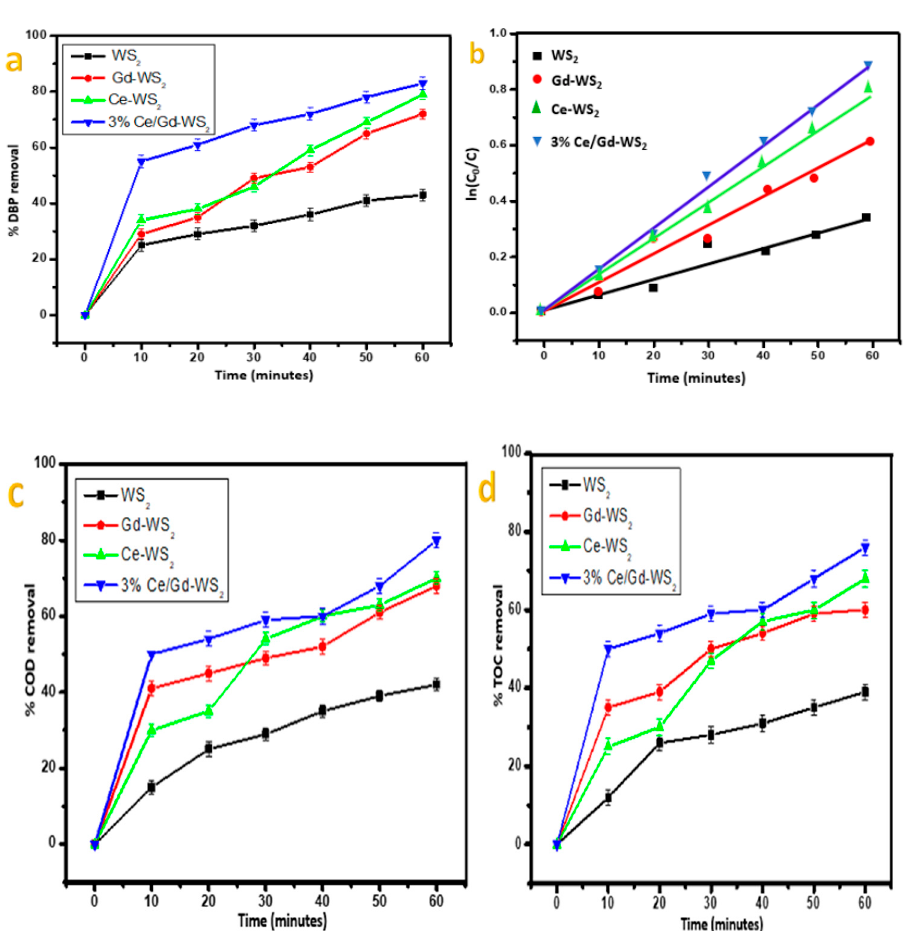
Figure 8. ( a ) The effect of photocatalysts degradation of DBP, ( b ) kinetic studies of DBP, ( c ) % COD removal, and ( d ) % TOC removal efficiency during photocatalytic degradation of DBP.